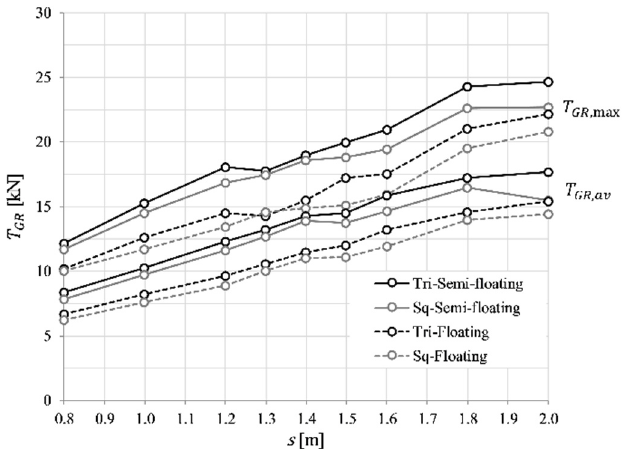
Figure 18. The maximum GR tensile load ( T GR , max ) and average GR tensile load ( T GR , av ) plotted against s .